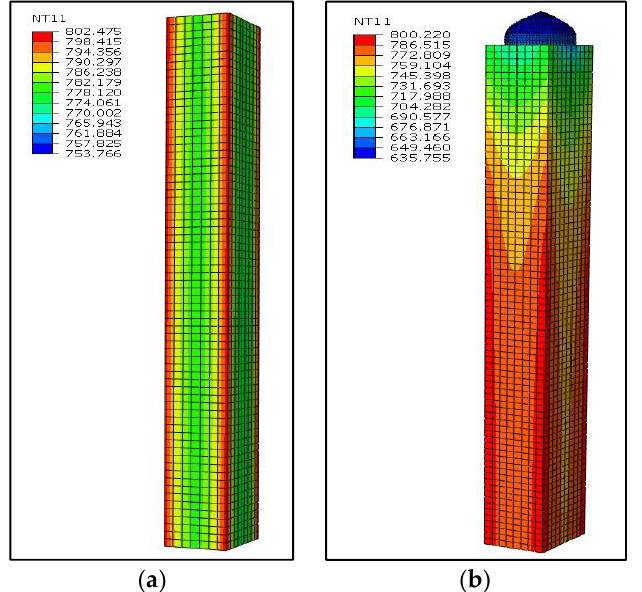
Figure 10. ( a ) Heat release contours of the conventional column and ( b ) heat release contours of the mimicked column with cone 10.